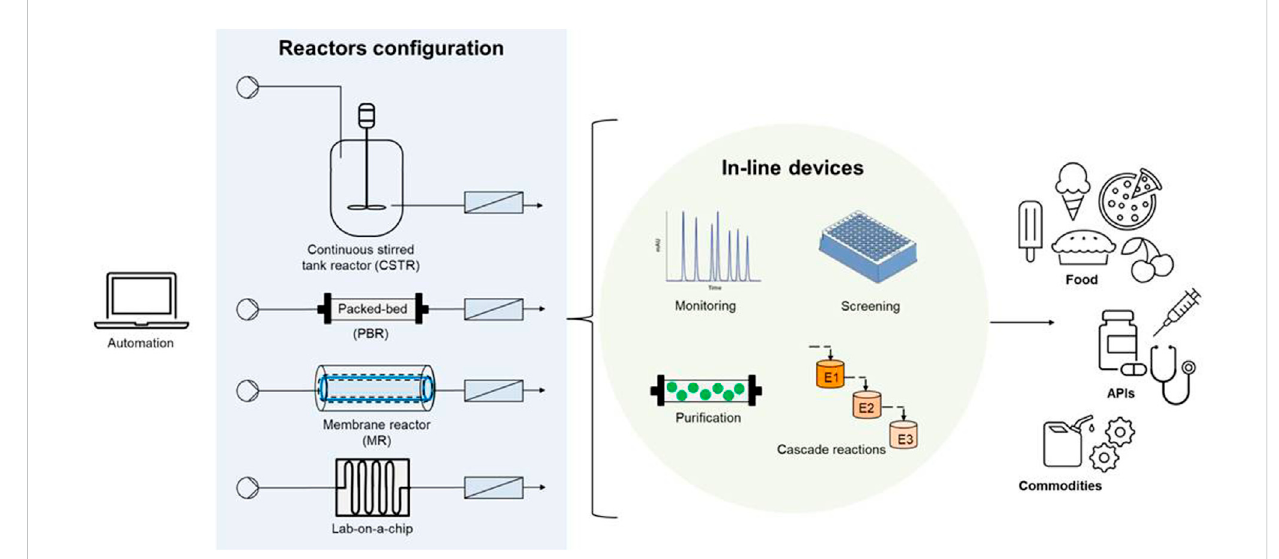
FIGURE 1 Continuous fl ow bioreactors at a glance: selected reactor layouts and applications discussed in the